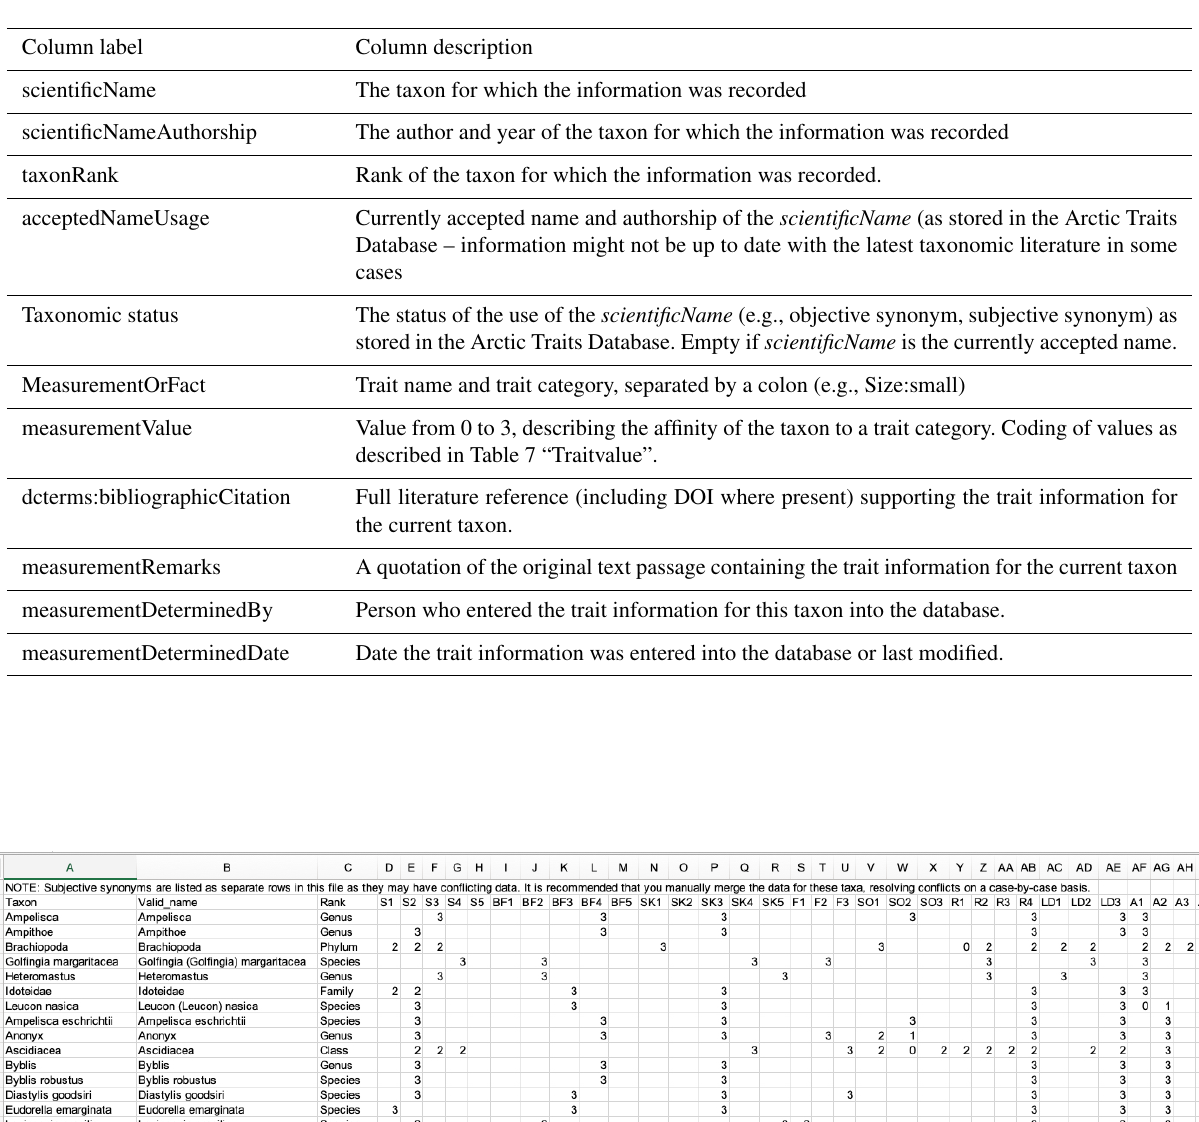
Table 8. List of fields returned by the Arctic Traits Database when “Darwin Core” is chosen as an export option from the download section. Darwin Core does not provide the same granularity as the “Data as columns” format. The output file consequently contains fewer details.